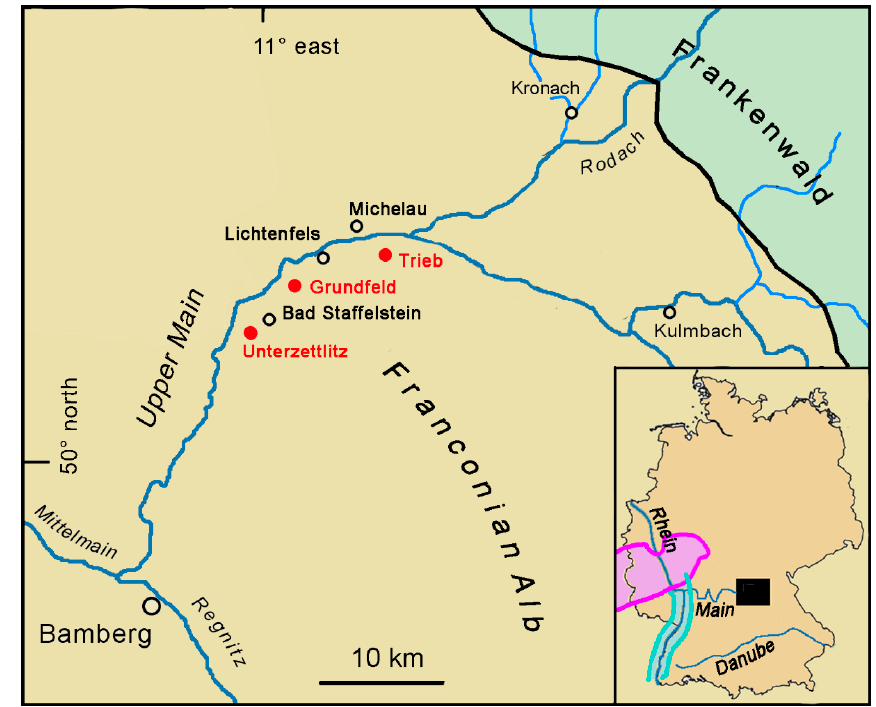
Figure 1. Location map of the Upper Main area/Bavaria. Inset: Map of Germany. Black rectangle = location of this map. Violet: Uplift area of the Rhenish Shield. Green area: Upper Rhine graben.